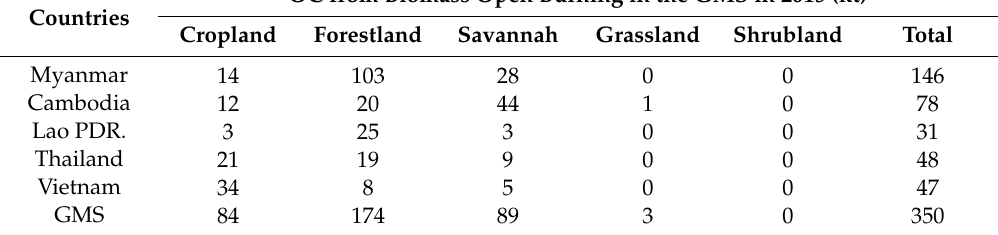
Table A10. The actual amount of OC from biomass open burning classified by vegetation types in the GMS in